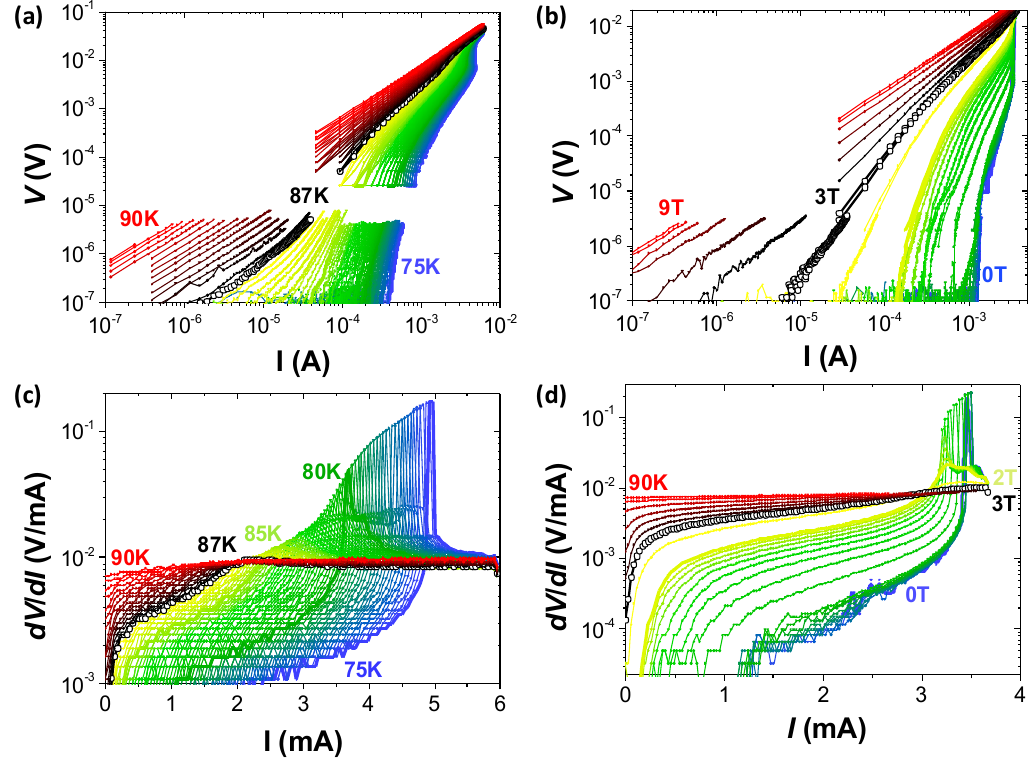
Figure 4. ( a ) I - V characteristics measured for a 300-nm-wide nanowire at ( a ) 1 T and different temperatures ranging from 75 K to 90 K with steps of 0.2 K. ( b ) 82 K at different applied magnetic fields ranging from 0 to 9 T with steps of 10 mT. ( c , d ) Derivative values dV / dI of curves shown in ( a , c ), respectively. Open symbols show the irreversibility points.